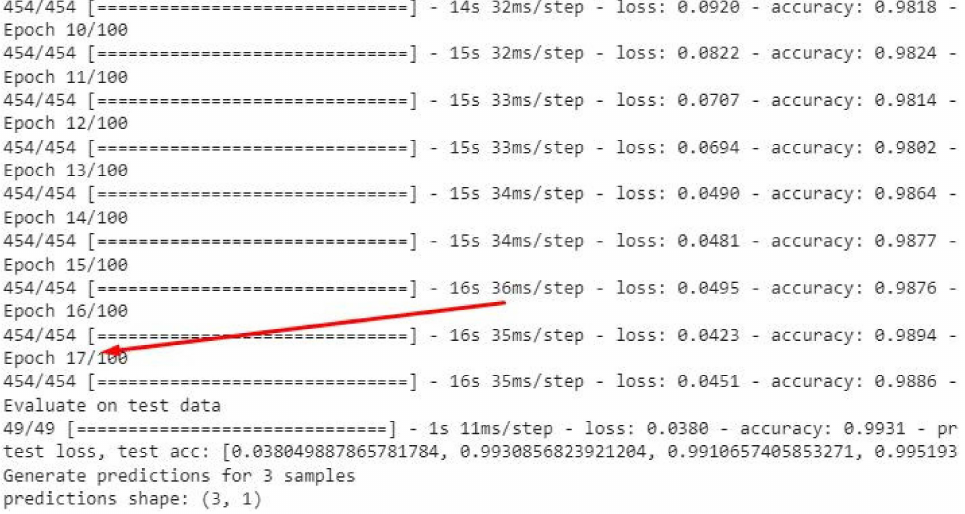
Figure 11. The number of epochs of the GRU